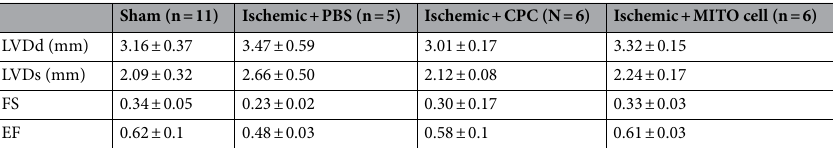
Sham (n = 11) Ischemic + PBS (n = 5) Ischemic + CPC (N = 6) Ischemic + MITO cell (n = 6)